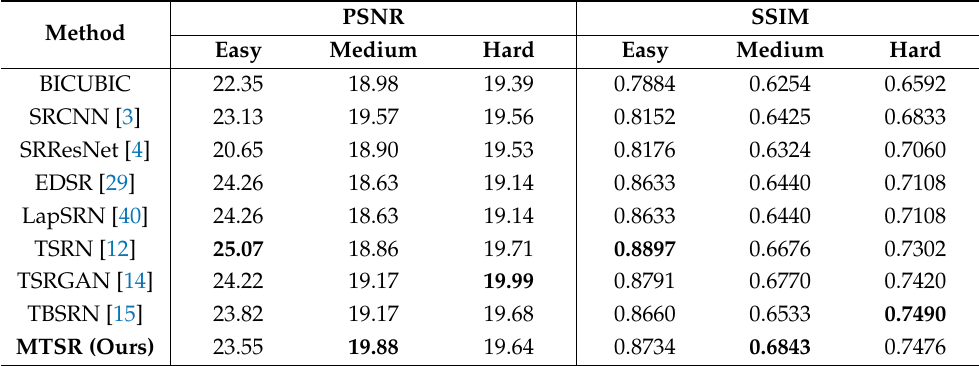
Table 5. Comparison of visual image quality based on PSNR and SSIM between the proposed method and representative STISR and SISR methods on the TextZoom dataset.